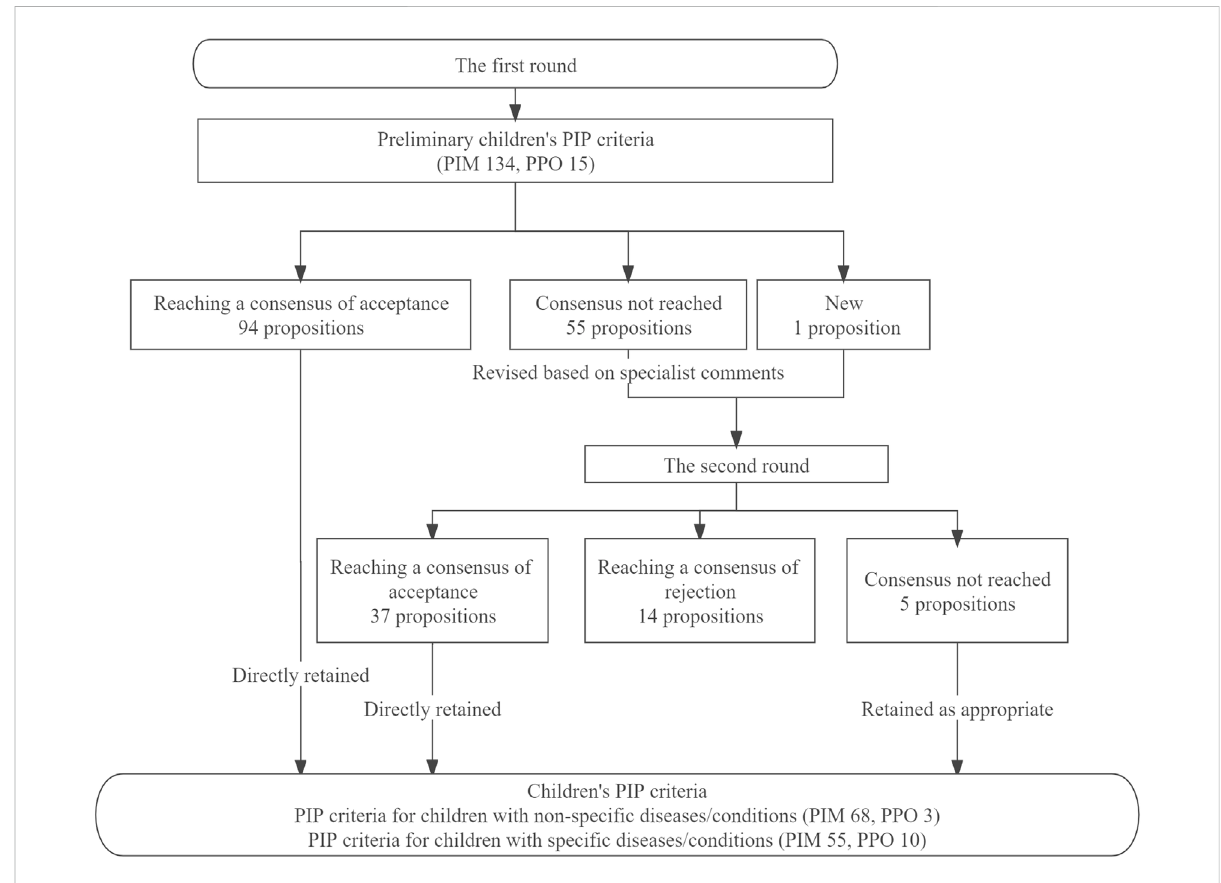
FIGURE 3 Results of the Delphi